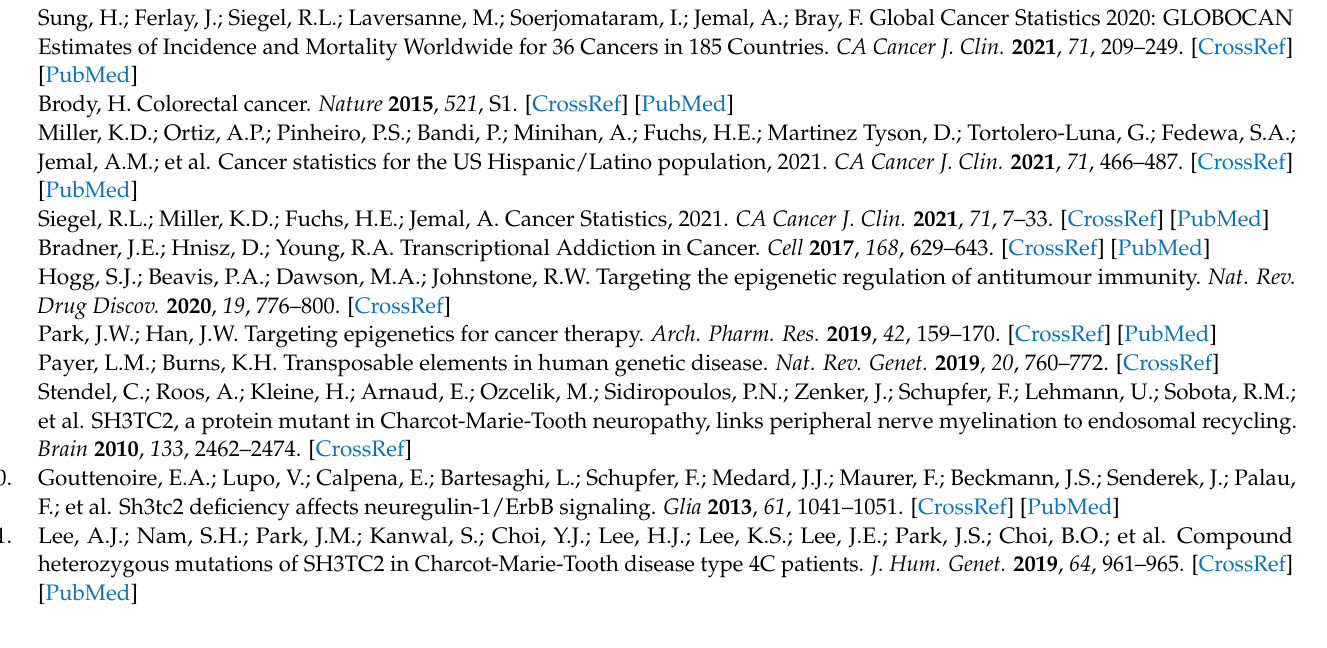
Table S7. Figure S8. Source Western-blot Images for Figure 6C. The black, blue, and orange frame indicates three independent siRNA transfection ex-periments. The quantification analysis for the western-blot could be found in Table S8. Table S1. Abbreviation of Cancer full Name in TCGA analysis. Table S2. The list of antibodies used in our study and dilution fold. Table S3. SH3TC2 siRNA sequences. Table S4. Primers used in qRT-PCR analysis. Table S5. The SH3TC2 expression and the clinical characteristic of CRC patients. Table S6. Source data for Figure 4A. Table S7. Source data for Figure 4C. Table S8. Source data for Figure 6A. Table S9. Source data for Figure